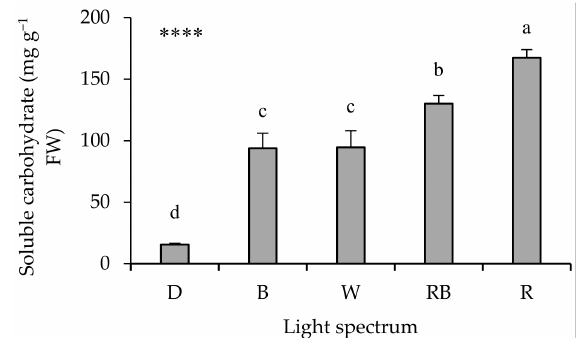
Figure 2. Total leaf carbohydrate content in grafted watermelon seedlings exposed for 12 days to either darkness (D) or different light quality regimes [blue (B), white (W), red and blue (RB), as well as red (R); see spectrum in Supplementary Figure S3]. Photosynthetic photon flux density was 20 ± 1 µ mol m − 2 s − 1 during the first 2 days, and 50 ± 1 µ mol m − 2 s − 1 during the following days. Nine plants per treatment were assessed. Different letters indicate that values are significantly different at p < 0.01 according to Duncan’s multiple range tests. Bars represent SEM. Significance at the 0.0001 probability level is indicated by